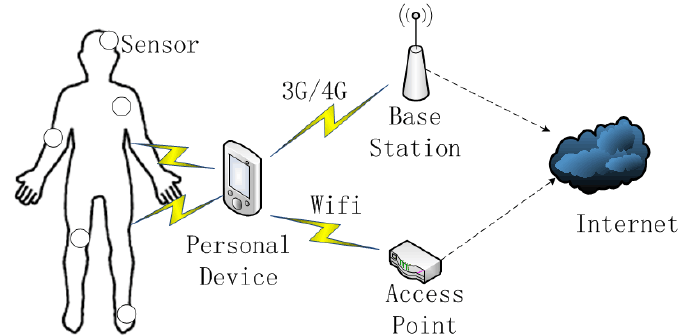
Figure 1. Body area network